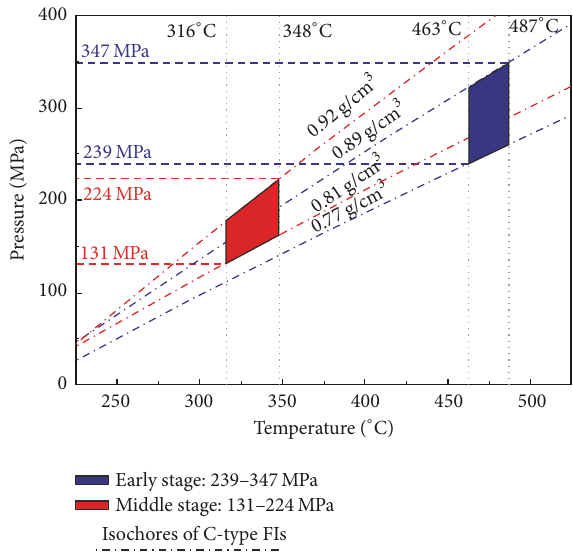
Figure 11: Pressure-temperature conditions for the early and middle stages in the Liyuan gold deposit.